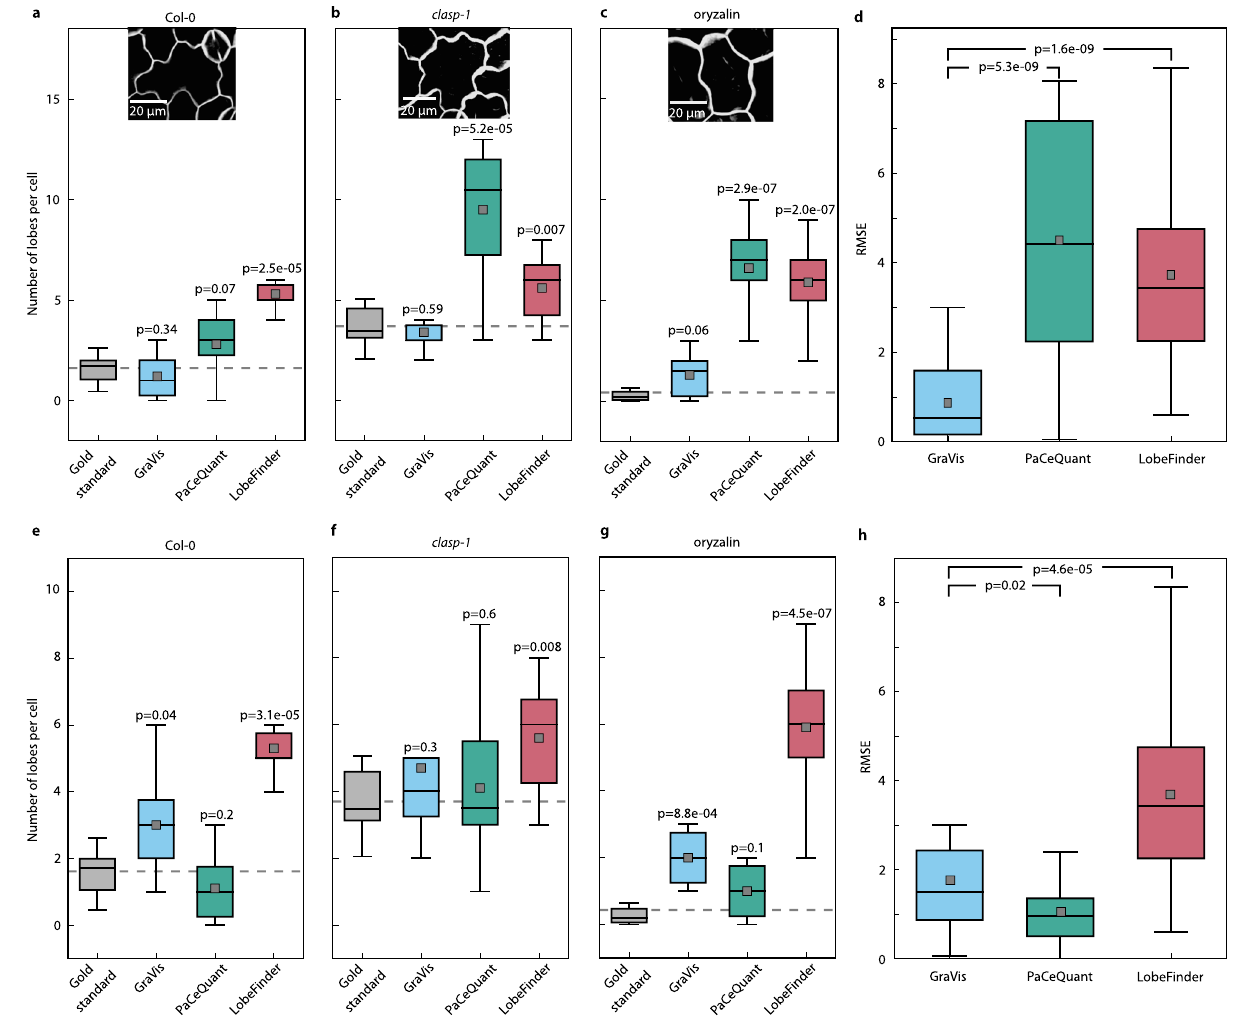
Fig. 6 Comparison of visibility graphs with other contending approaches to counting the number of lobes without tri-cellular junctions in leaf pavement cells. The comparison involves three computational approaches: PaCeQuant 14 , based on the contour curvature, LobeFinder 6 , based on the convex hull, and LOCO-EFA 15 , based on elliptical Fourier analysis. Since LOCO-EFA does not distinguish between true lobes and tri-cellular junctions, it was removed from the comparison, but is included in the comparison of tools based on the total number of lobes (Supplementary Fig. 15). The quantitative comparison is based on a gold standard that includes n = 30 Arabidopsis pavement cells obtained from each of the three scenarios: a , e wild type, b , f clasp-1 mutant, and c , g oryzalin treatment, all with manually annotated lobes by 20 experts. The clasp-1 data used for the gold standard (96 h after germination) differ from the clasp-1 data used in the comparison of different genotypes (120 h post dissection), as the images were captured at different time points. Shown is the competitive comparison using a – d default parameters and e – h tuned parameters to detect the number of lobes without tri- cellular junctions. The dotted line denotes the mean of the gold standard, i.e., manual detection by 20 experts, for the respective scenario. While GraVis performs best based on the residual mean square error (RMSE) using d default parameters, it performs as good as PaCeQuant using h tuned parameters. p values were determined with a two-sided two-sample t test and were Benjamini – Hochberg adjusted. Boxplots are shown with median (horizontal line), mean (gray square), 25th and 75th percentiles (box edges), and 1.5-fold of the interquartile range (whiskers). Source data are provided as a Source Data fi